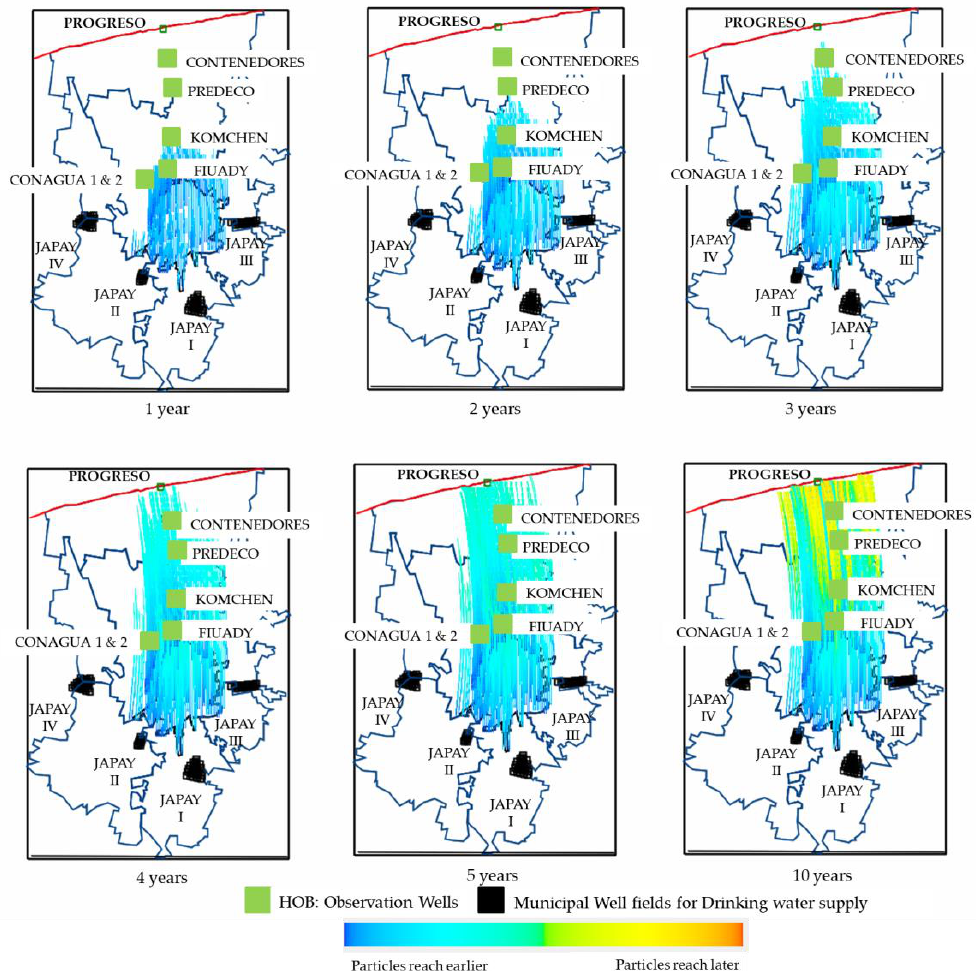
Figure 5. Particle tracking with Merida city as the particle release area. Two particles per axis were released for each grid corresponding to Merida City. A clear movement northward indicates the theoretical vulnerability of small communities between Merida and